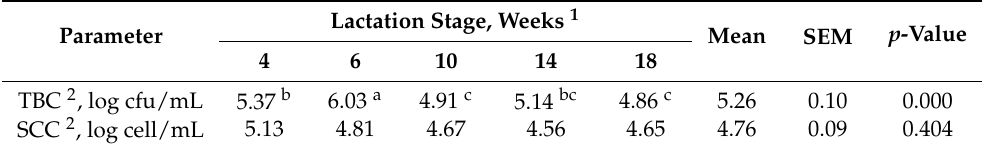
Table 3. Total bacteria (TBC) and somatic cell (SCC) counts of red deer milk collected over the 18-week lactation period. Lactation Stage, Weeks 1 Parameter